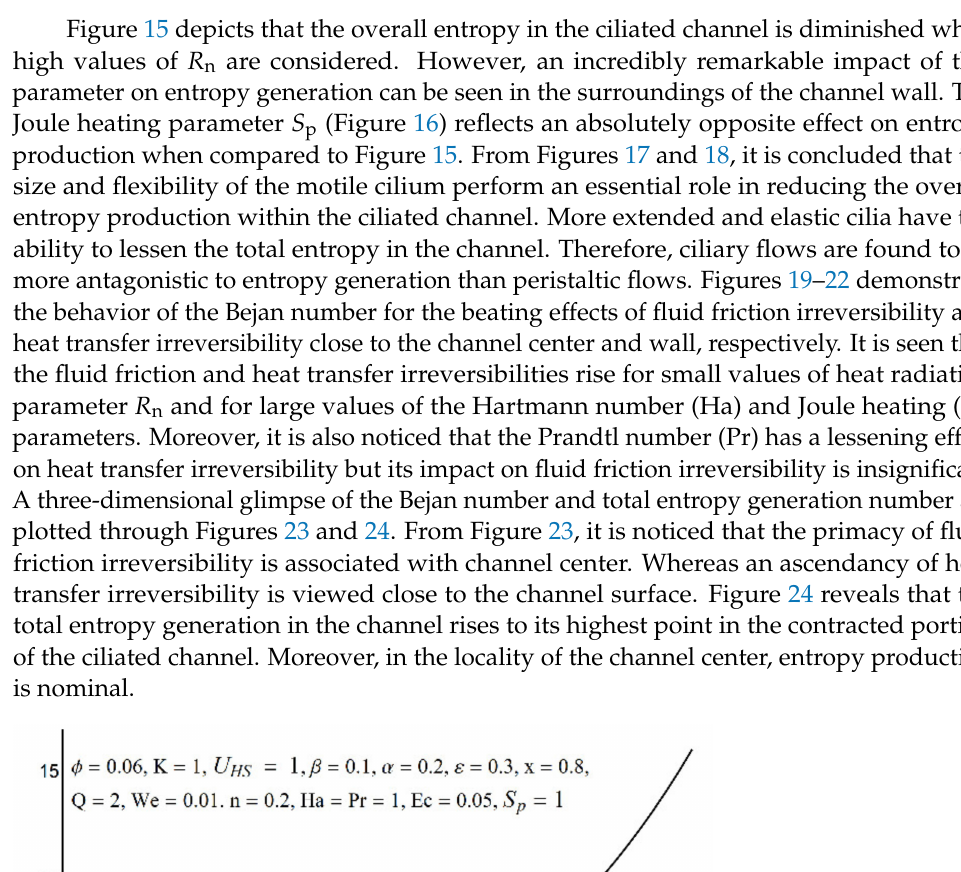
Figure 14. The temperature field for various values of K.